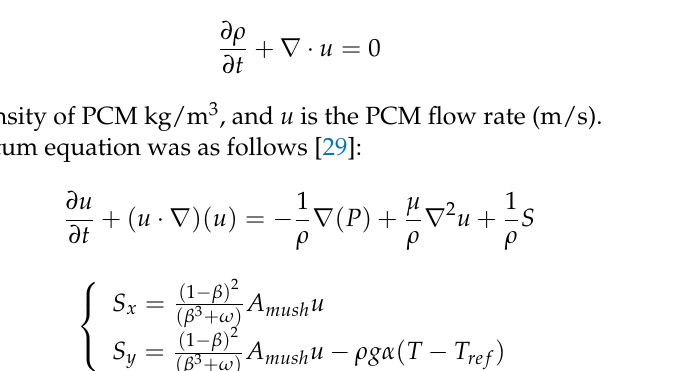
Figure 2. Computational model.